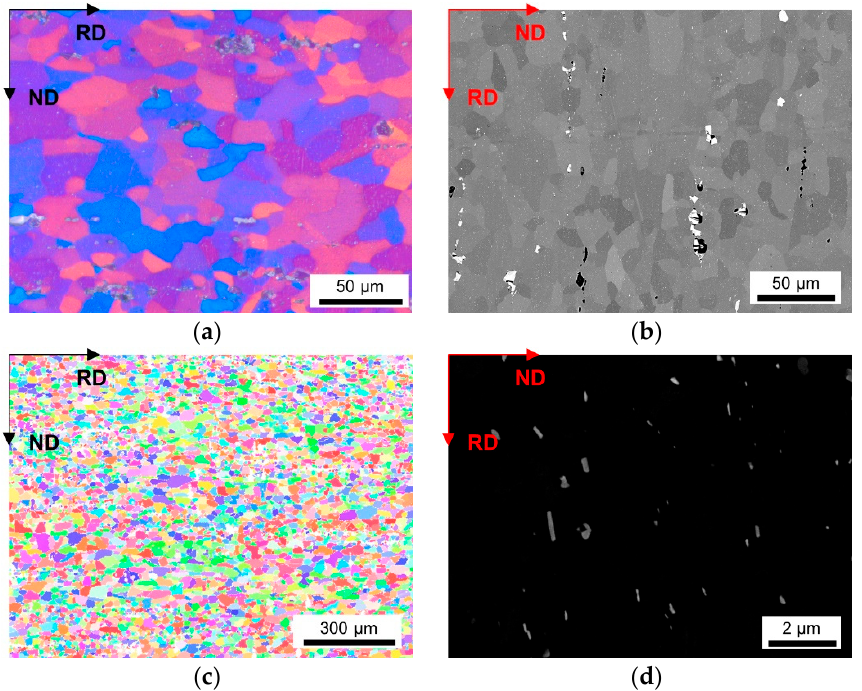
Figure A12. Microstructure of the soft annealed LFe-HMn cast under S-C conditions, homogenized at 550 °C and cold rolled to a CRD of 35%. ( a ) LOM. ( b ) BSE image. ( c ) EBSD IPF map in RD–ND plane. ( d ) BSE micrograph showing dispersoids.